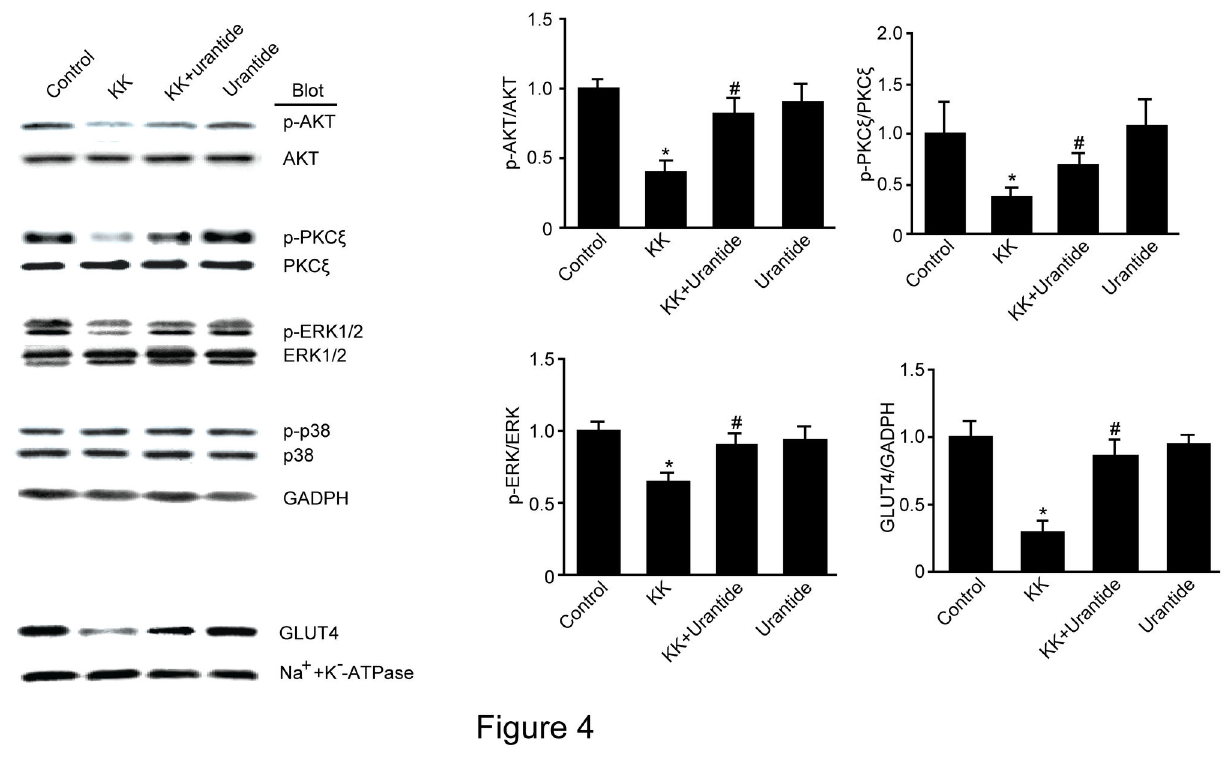
Figure 4. Effect of urantide on GLUT4 protein expression and PKC, AKT, ERK protein phosphorylation. KK mice were administrated urantide (30 µg/kg/day) for 14 days prior to western blot analysis with antibodies against GLUT4, PKC, AKT, ERK and p38MAPK. Equal loading was confirmed by reprobing the membranes with GAPDH or Na + -K + -ATPase antibody. Control: C57BL/6J mice were treated with saline for 14 days; Urantide: C57BL/6J mice were treated with urantide for 14 days; KK:KK mice were treated with saline for 14 days; KK+Urantide: KK mice were treated with urantide for 14 days. Data are presented as the relative increase compared with control (100%; n=3, * P <0.05 vs control; # P <0.05 vs KK group). doi: